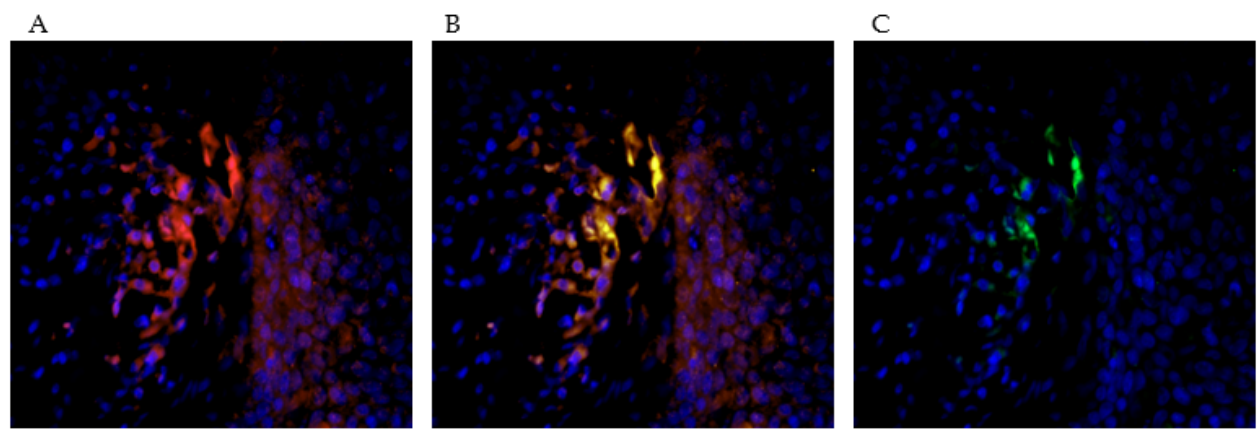
Figure 4. The picture series ( A – C ) demonstrate the double staining with PPAR γ (red) and CD68 (green). This allows a subtyping of CD68-positive macrophages into M2-polarized and M2-unpolarized macrophages. PPAR γ acts as a marker for the M2-polarization of the macrophages. In the selected tissue sections, it was found that more doubly stained, M2-polarized macrophages are resident in the immediate environment and within the tumor association than in the extratumoral